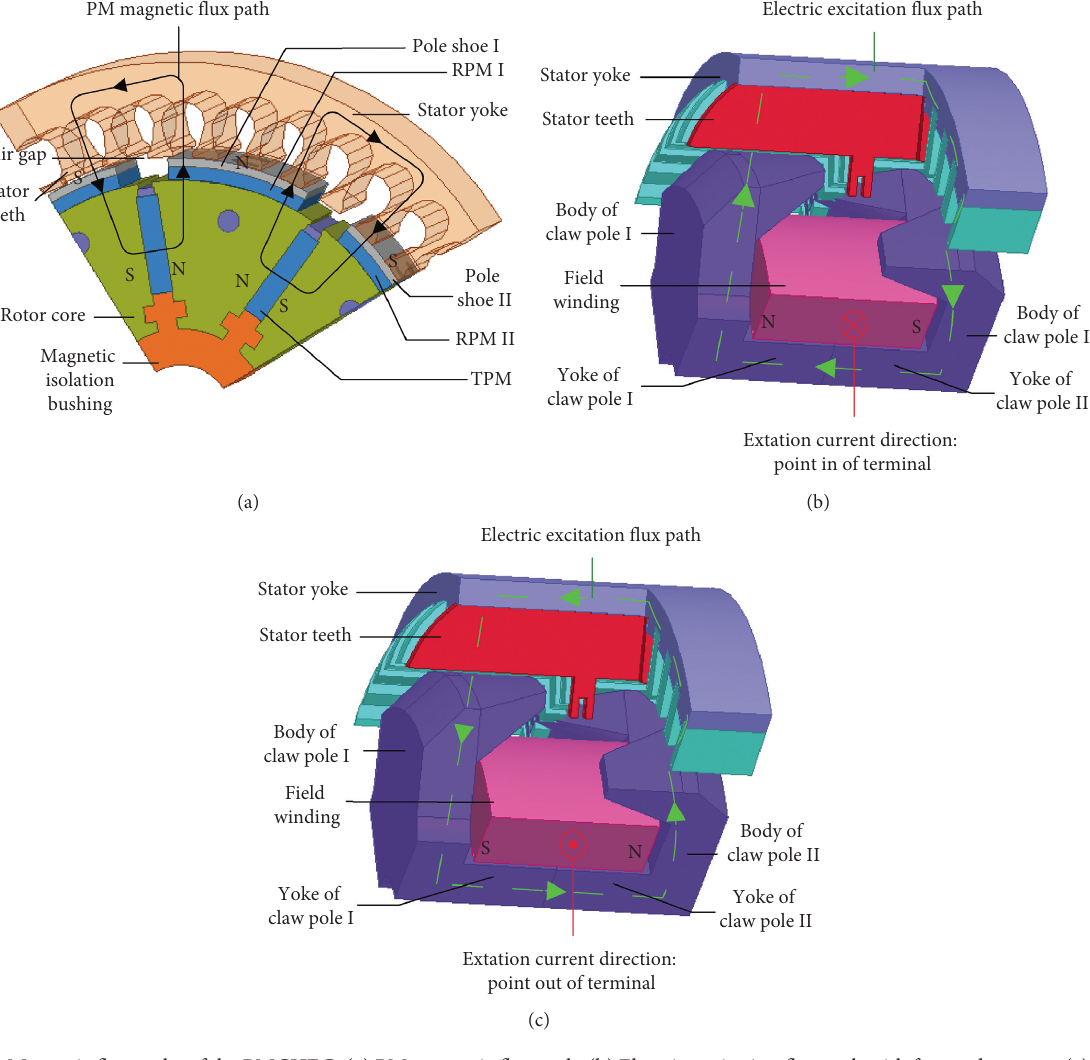
Figure 2: Magnetic flux paths of the PMCHEG. (a) PM magnetic flux path. (b) Electric excitation flux path with forward current. (c) Electric excitation flux path with reverse current.